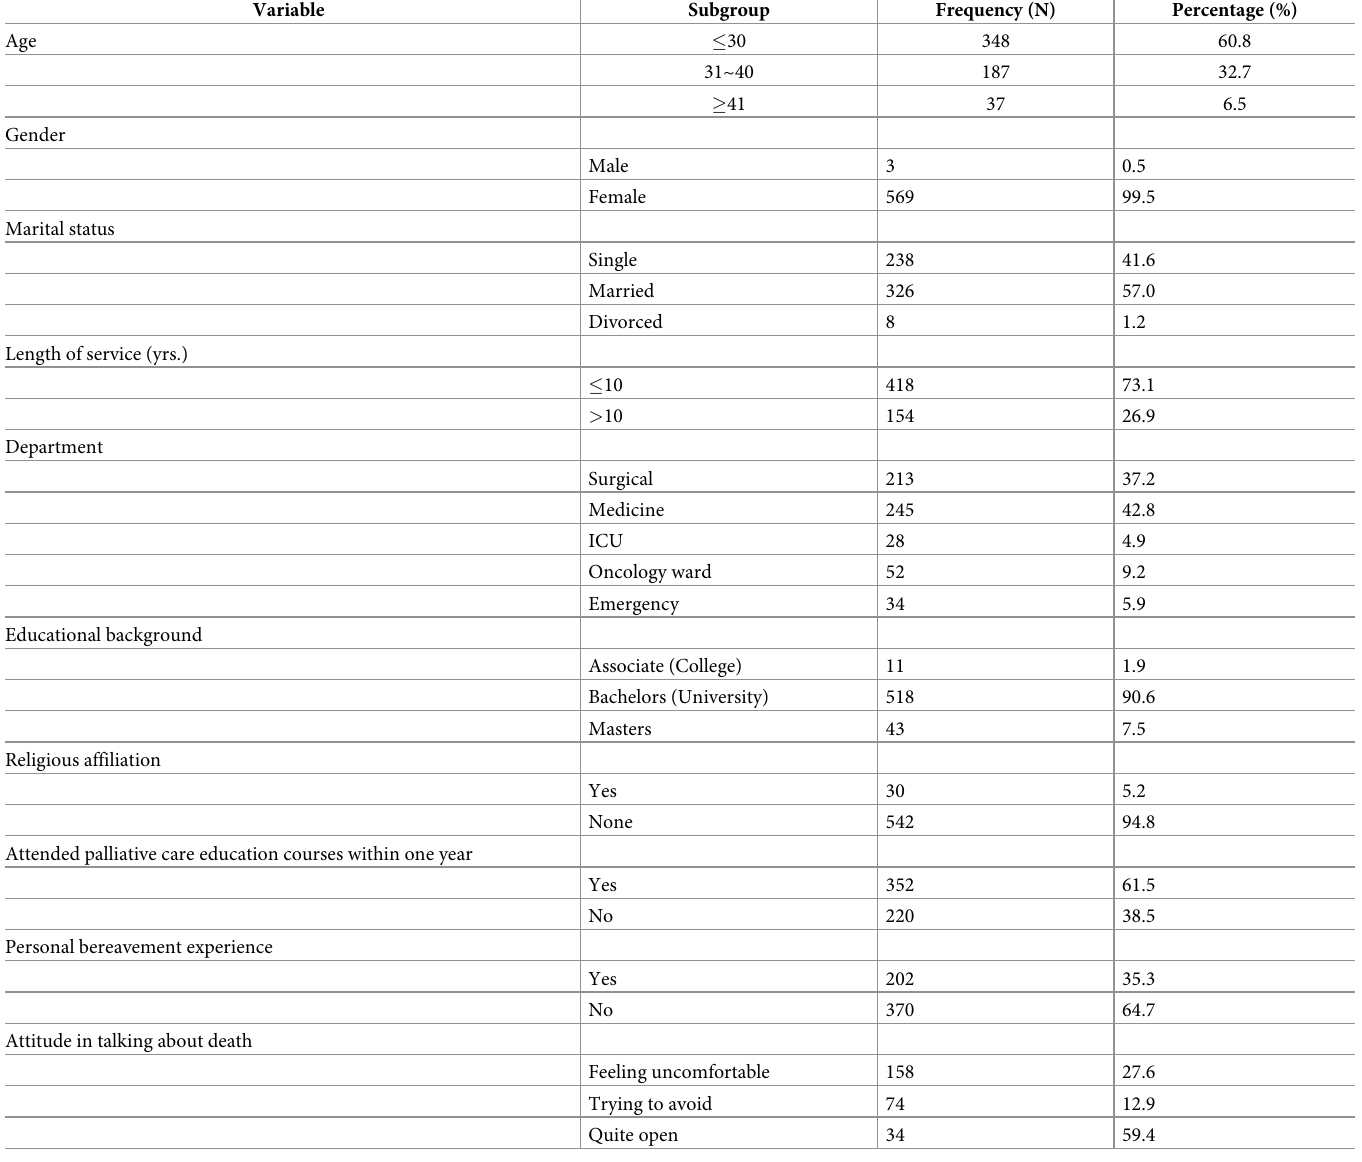
Table 1. Sociodemographic and work characteristics of the participants (N = 572).